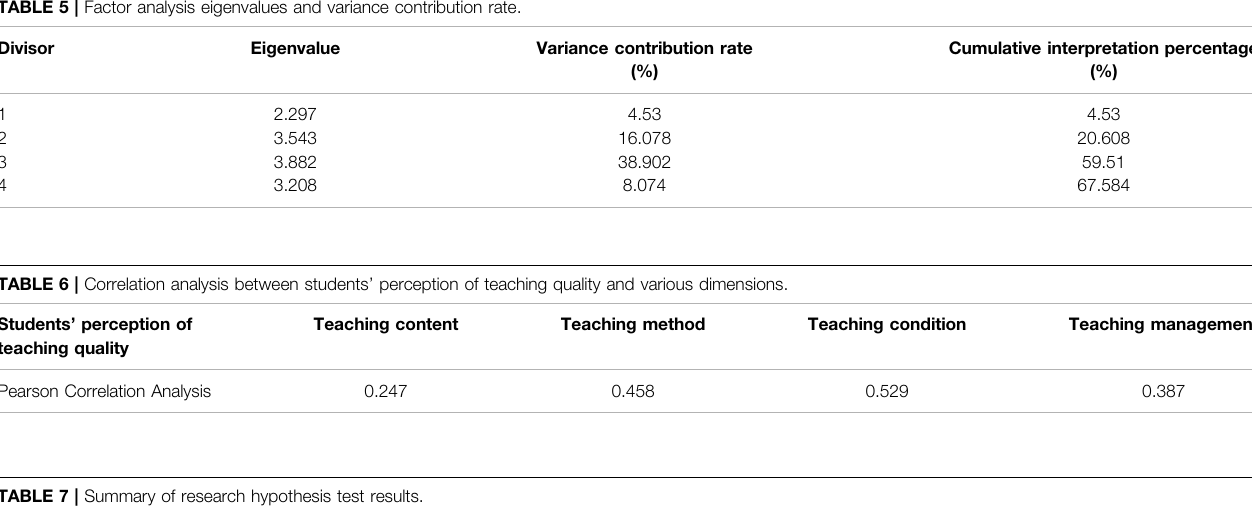
TABLE 7 | Summary of research hypothesis test results.